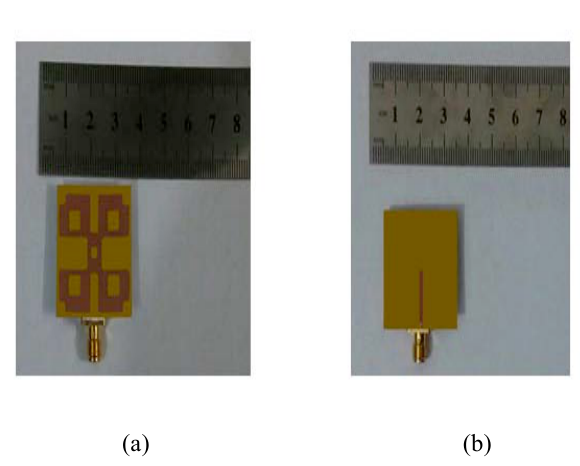
Figure 7 : (a) the top and (b) the bottom views of the fabricated antenna prototype.